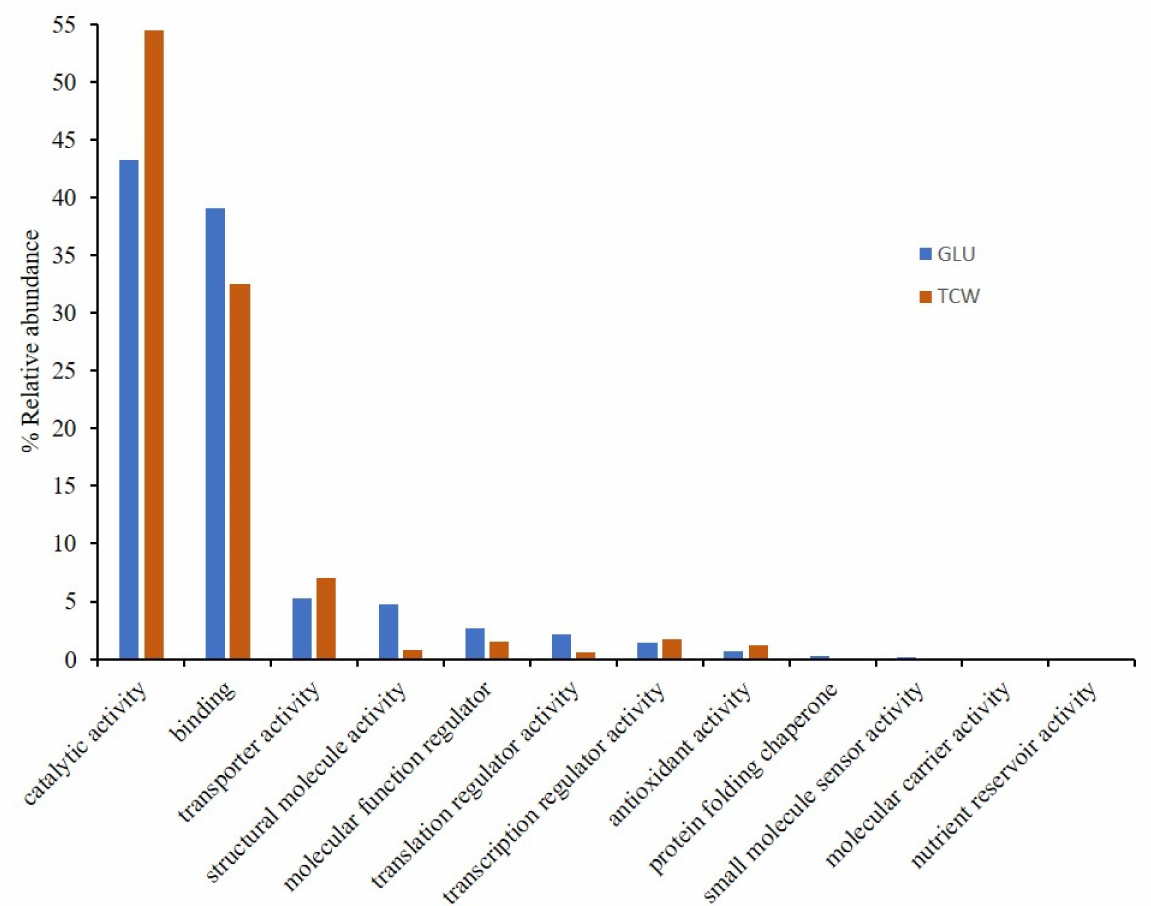
Figure 1. Gene ontology (GO) classification by the molecular function (level 2 of categorization) of proteins exclusively identified or overexpressed in B. cinerea proteomes (membranome, phosphoproteome, phosphomembranome, and se- cretome), under GLU and TCW conditions, as the sole carbon source. Relative abundance represents the percentage of membrane-associated phosphoproteins identified in each category relative to the total number of protein GO annotations in this